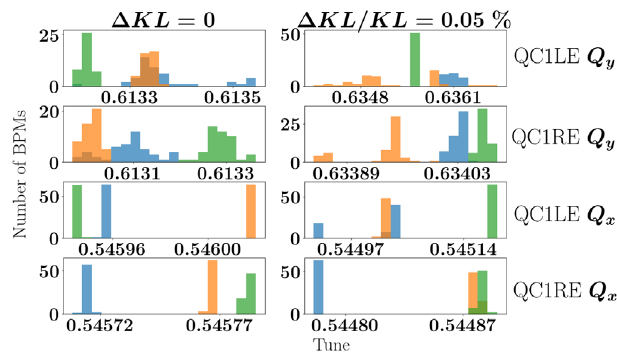
FIG. 13. Simulated and measured tune shift when modulating the inner quadrupoles in HER. The simulations are done using β (cid:1) ¼ 3 . 2 mm. The uncertainty in the recorded tune measure- y ments are 4 × 10 − 4 for the modulation of the QC1LE magnet and 2 × 10 − 4 for the modulation of the QC1RE magnet. The lines have been made by fitting the average β function and using Eq. (3). The integrated strength of the magnets during the measurements were KL 0 ¼ − 1 . 15 m − 1 for QC1LE and KL 0 ¼ − 1 . 09 m − 1 for